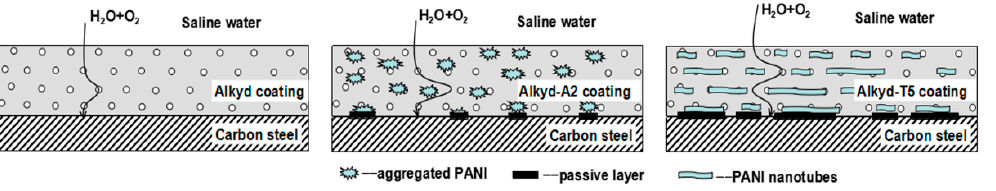
Table 2. Electrochemical parameters calculated from EIS spectra of alkyd coatings containing PANI nanostructures immersed in 3.5 wt% NaCl solution.